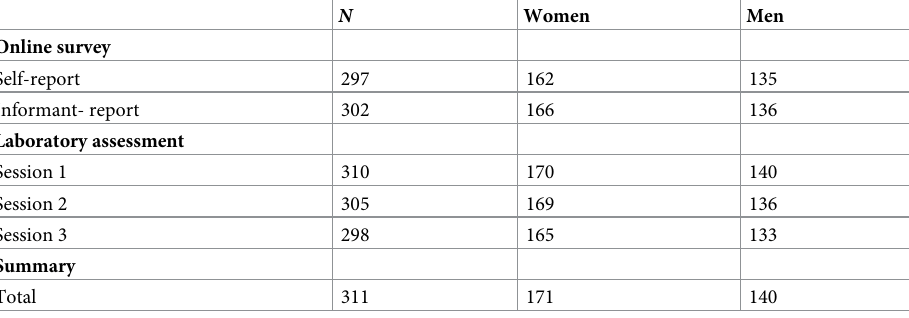
Table 2. Number of participants per data